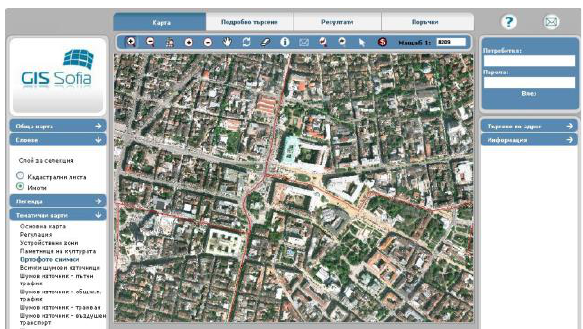
Figure 4. WEB GIS for Sofia